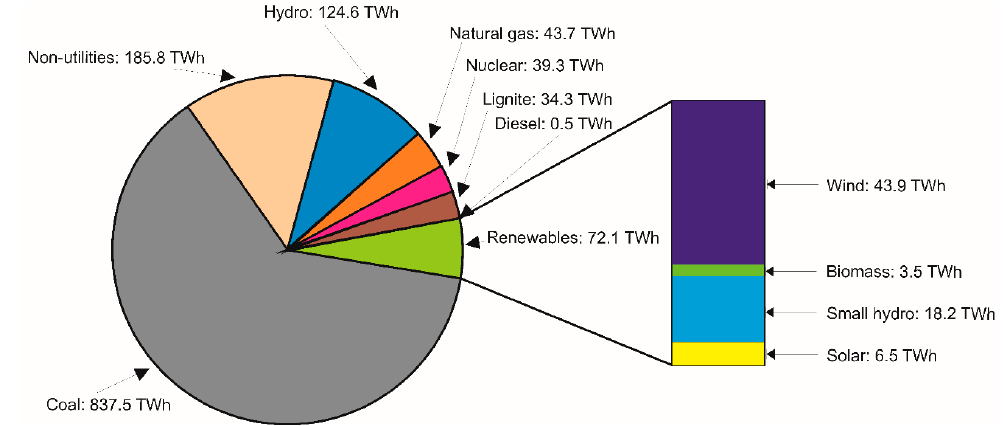
Figure 2. Electricity mix in India 2015 [2].